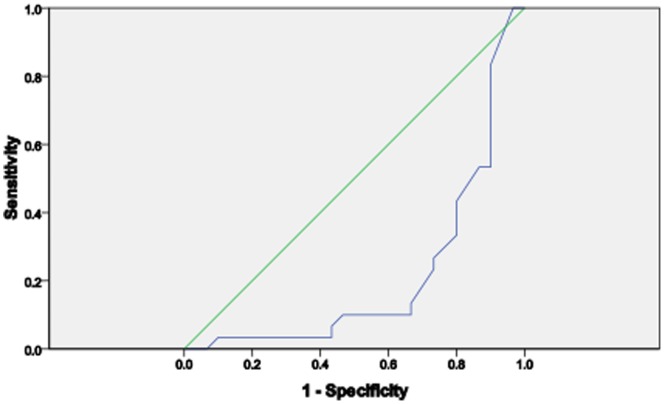
The ROC curve of copeptin in SCA subjects.